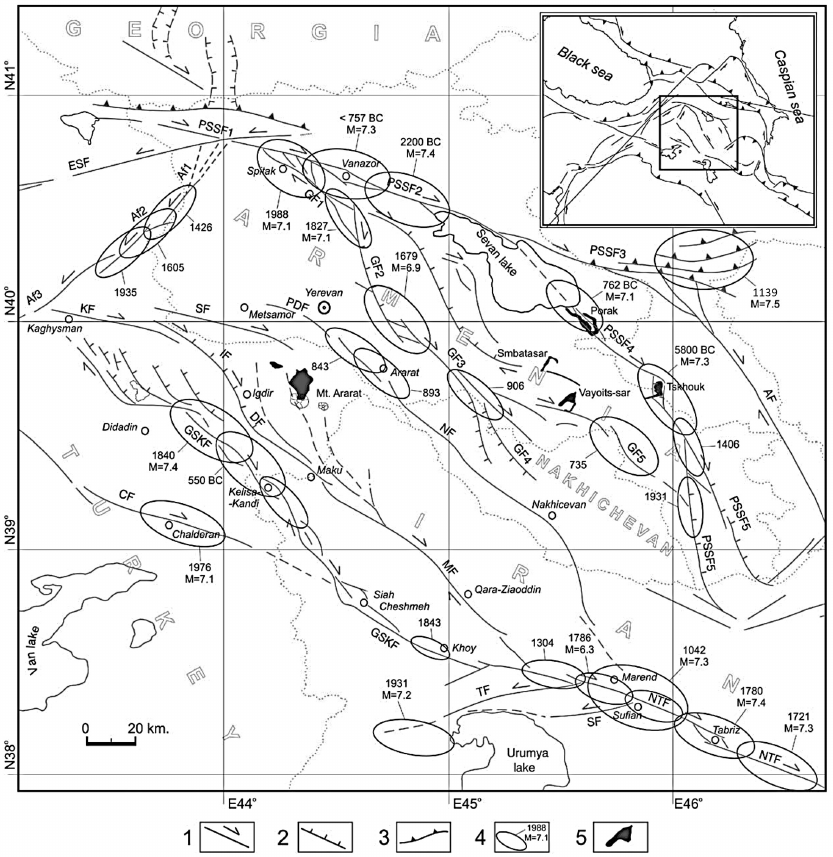
Figure 3. Active faults and historical earthquakes (marked by elliptic epicentral zones) in Armenia, southern Georgia, western Azerbaijan, northern Iran, and eastern Turkey (modified from [9]; we revised the date of the event in the eastern part of the PSSF to 1139 because it was incorrectly reported as 1319 in the original map). The legend indicates faults, earthquakes, and volcanic features as: 1, strike-slip faults; 2, normal faults; 3, thrust faults; 4, epicenters of strong earthquakes; and 5, volcanic deposits associated with Holocene and historical seismically triggered eruptions. Faults are labelled as: GF, Garni Fault; PSSF, Pambak-Sevan-Syunik Fault; ESF, Zheltorechensk-Sarighamish Fault; AF,